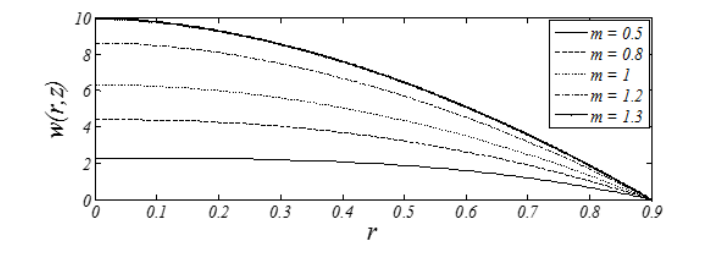
Fig. 3 Velocity variation for F=2, δ =0.4, n=2, a=0.2, b=0.4.